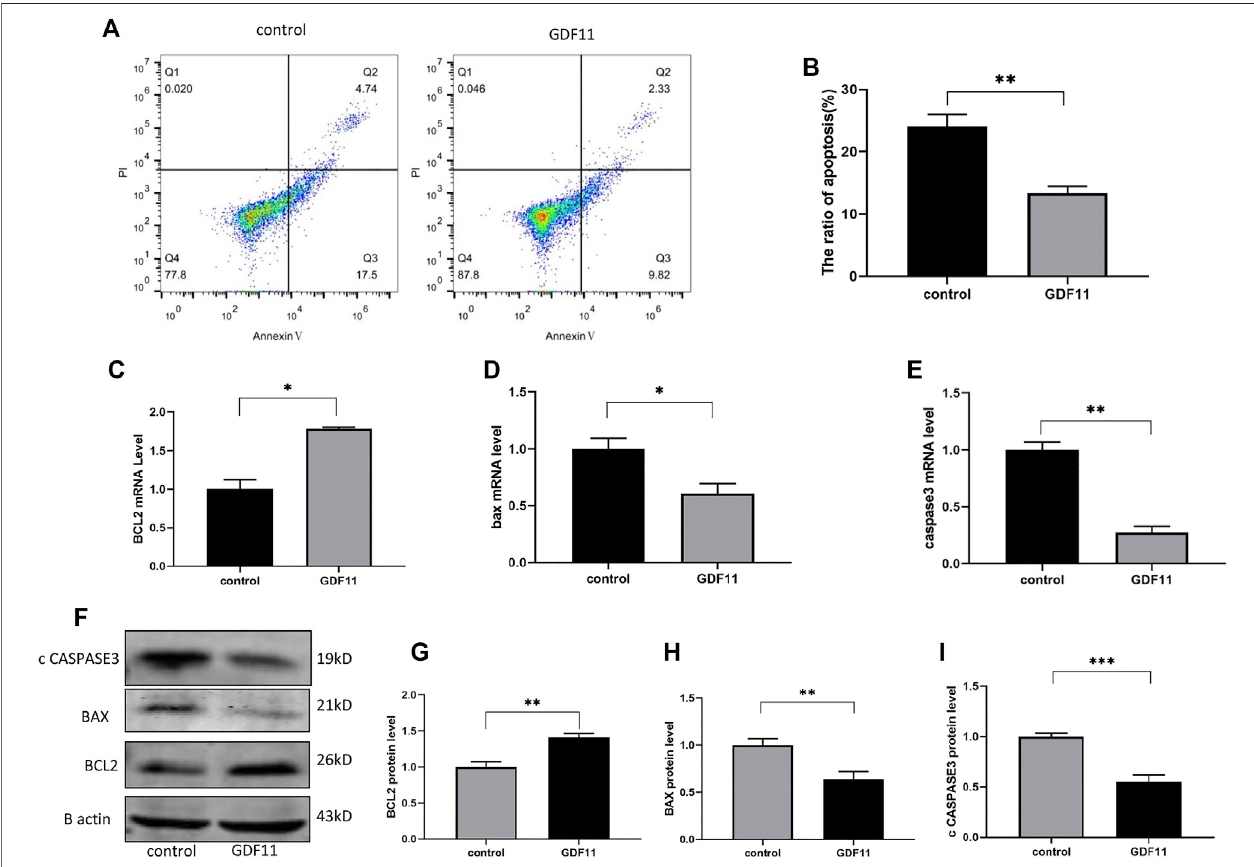
FIGURE 2 | GDF11 inhibited apoptosis of DGR in vitro . (A and B). Flow cytometry was used to detect the degree of apoptosis of DRG after cultured with recombinantGDF11for3days. (C,DandE). DRGwerecultured withrecombinantGDF11for3 days,andmRNAexpression ofapoptosis-related genesBcl2,Baxand caspase3 were detected by RT-PCR. (F, G, H and I). After DRG were cultured with recombinant GDF11 for 3 days, the protein expressions ofapoptosis-related genes Bcl2, Bax and caspase3 were detected by Western blot. Statistical analysis was based on at least three different biological samples and three technical replicates, p < 0.05 was considered to be statistically signi fi